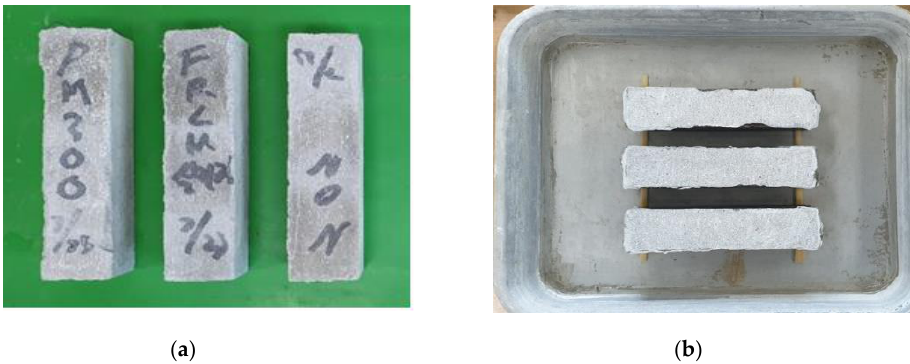
Figure 2. Evaluation of the water resistance of the matrix: ( a ) specimens; ( b ) dipping. Table 4. Water resistance results.